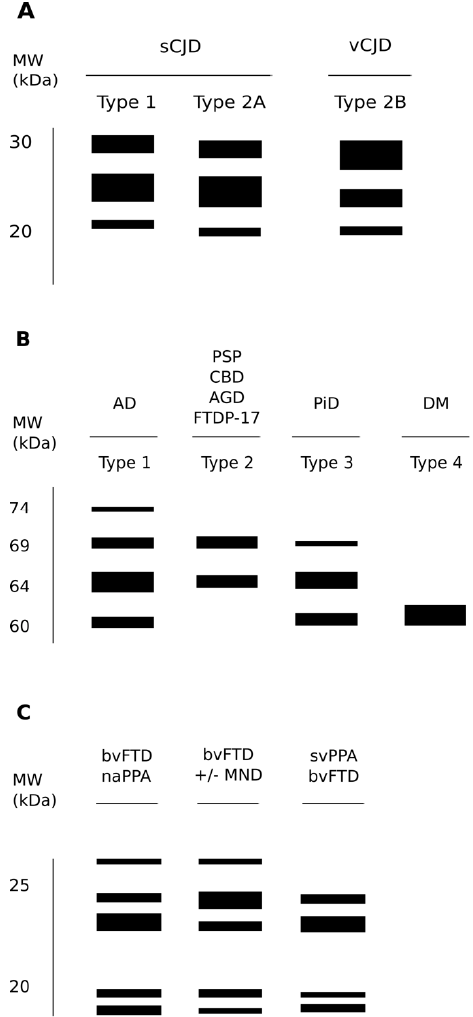
Figure 3. Representative western blot profiles of the prion and prion-like pathological proteins extracted from diseased brains: ( A ) A schematic representation of human PrP Sc types after PK digestion. In the sCJD cases, the PK cleavage of PrP Sc results in type 1 when the unglycosylated PK-resistant fragment presents a molecular mass of 21 kDa and in type 2A when the it has a molecular mass of 19 kDa. In both cases, there is a predominance of the mono-glycosylated band over the others. vCJD presents a different pattern associated with the presence of the unglycosylated PK-resistant fragment of 19 kDa and the predominance of the di-glycosylated band in the glycoform ratio (type 2B). ( B ) The four different electrophoretic patterns of pathological tau proteins are composed of bands at 60, 64, 69 and 74 kDa, which correspond to the pathological tau that are found in aggregates in different tauopathies (listed on the top of each pattern). ( C ) The representative immunoblots with the phosphorylated TDP-43 specific antibody, pS409/410. FTLD-TDP type B pathology shows three major bands at 23, 24 and 26 kDa and two minor bands at 18 and 19 kDa, with the predominance of the 24 kDa band. Type C pathology shows two major bands at 23 and 24 kDa and two minor bands at 18 and 19 kDa with the 23 kDa band being the most represented. Type A pathology is not distinctive but intermediate between the other two. sCJD: sporadic Creutzfeldt-Jakob disease; vCJD: variant Creutzfeldt-Jakob disease; AD: Alzheimer’s Disease; PSP: Progressive Supranuclear Palsy; CBD: Corticobasal Degeneration; AGD: Argirophilic Grain Disease; FTLD-17: Frontotemporal Dementia linked to chromosome 17; PiD: Pick’s Disease; DM: myotonic dystrophy; bvFTD: behavioural variant of Frontotemporal Dementia; naPPA: nonfluent/agrammatic primary progressive aphasia; MND: motor neuron disorder; svPPA: semantic variant primary progressive